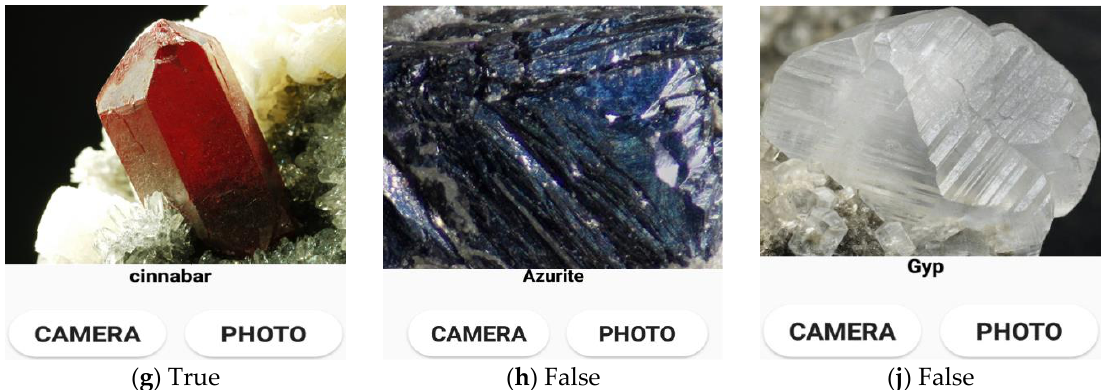
Figure 9. Samples of recognition results. ( a – c ) are from the comprehensive model, ( d – f ) are from the Inception-v3 model trained with feature extraction images, ( g – j ) are from the Inception-v3 model without feature extraction.